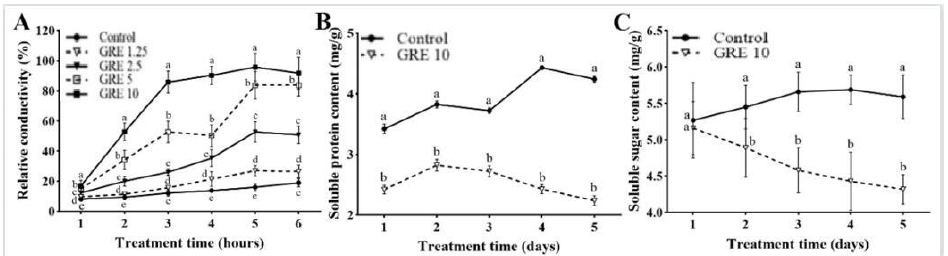
Figure 3. Effects of different concentrations of GRE on relative conductivity ( A ) and the effect of 10 mg/mL of GRE on soluble protein ( B ) and soluble sugar ( C ) contents in F. solani . The bars on the curves represent standard deviations, and different letters at the same time point represent significant differences ( p < 0.05).